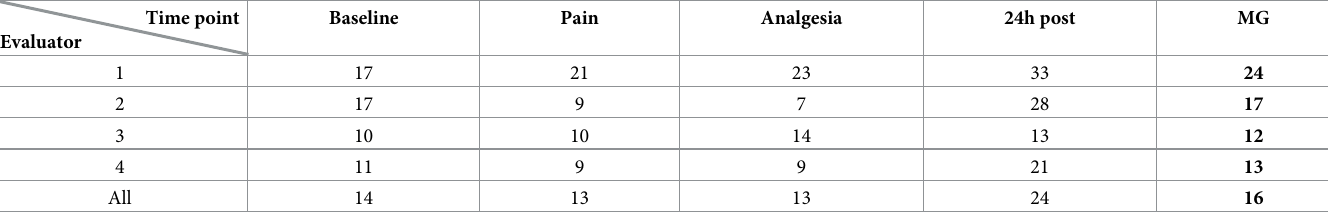
Calculation based on 58 rabbits evaluated twice by four evaluators. RPBS: Rabbit pain behaviour scale MG—data of grouped time points ( baseline + pain + analgesia + 24h post ). The diagnostic uncertainty zone was 3 to 4; < 3 indicates pain-free rabbit (true negative) and � 4 indicates rabbit suffering pain (true